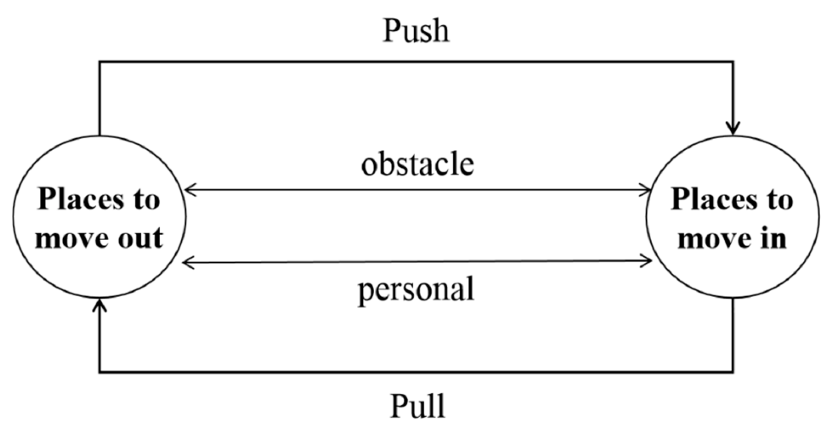
Figure 2. Push-Pull theory framework.